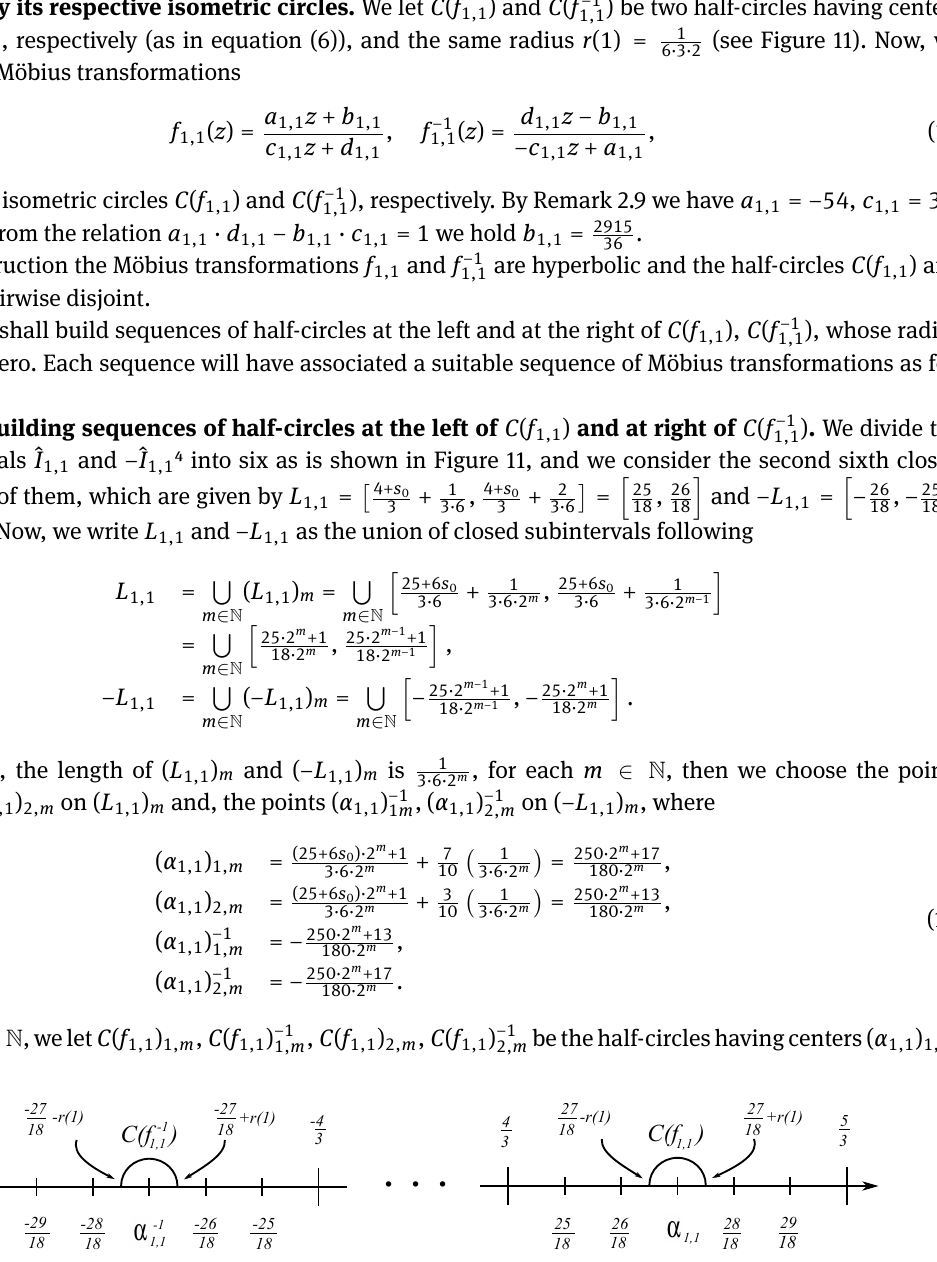
respectively, and the same radius ( r (1)) m = 1 2, m